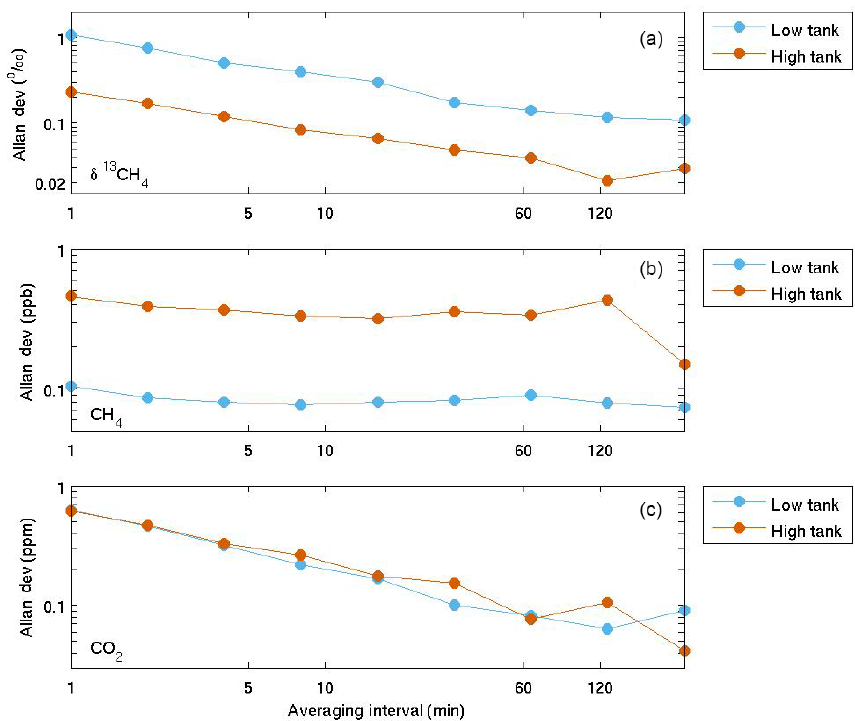
Figure 2. Allan standard deviation for (a) δ 13 CH 4 , (b) CH 4 , and (c) CO 2 for a high CH 4 mole fraction tank (9.7ppm CH 4 , ∼ 400ppm CO 2 , − 38.3‰ δ 13 CH ∼ 400ppm CO − 23.7‰ δ 13 CH 4 ; orange) and a low (1.9ppm CH 4 , 2 , 4 ) tank (blue). The x axis is truncated to focus on minimum averaging times required to achieve the desired compatibility